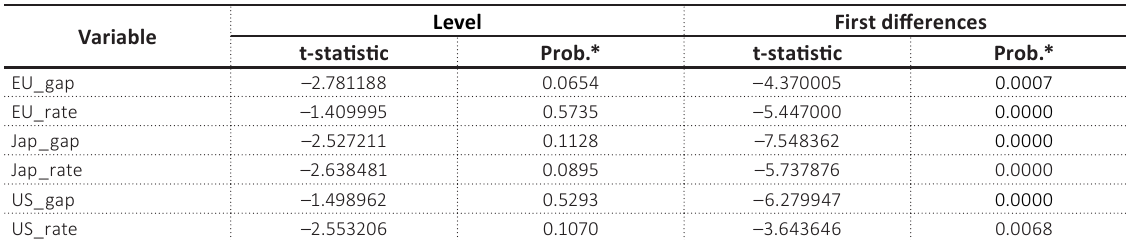
Table A3. The stationarity test